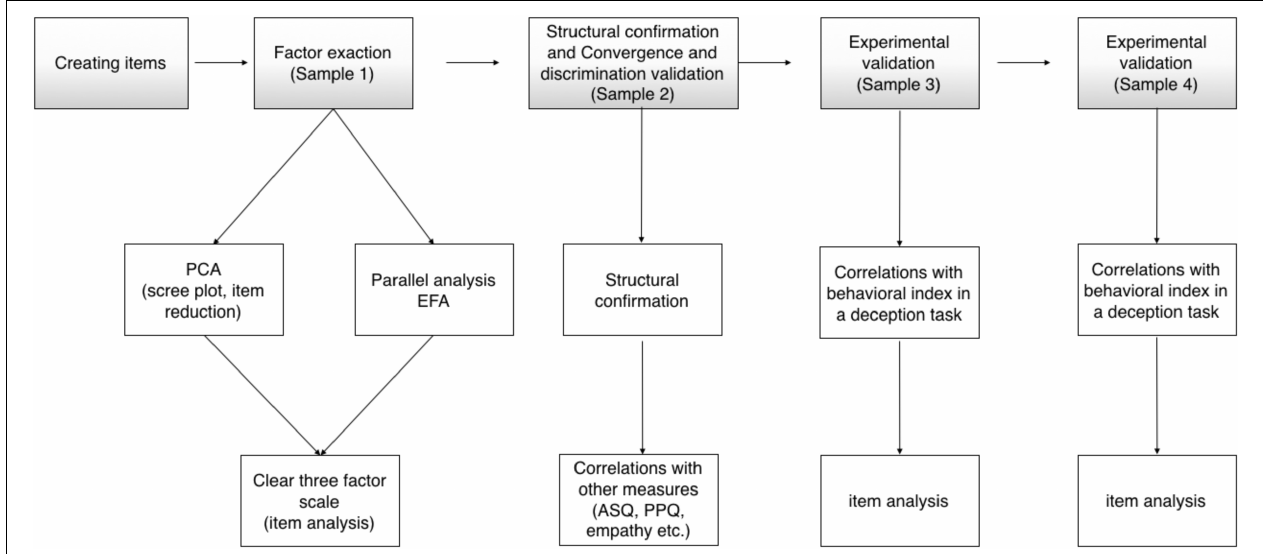
FIGURE 2 | The flow chart depicting the processes to develop and validate IMQ.